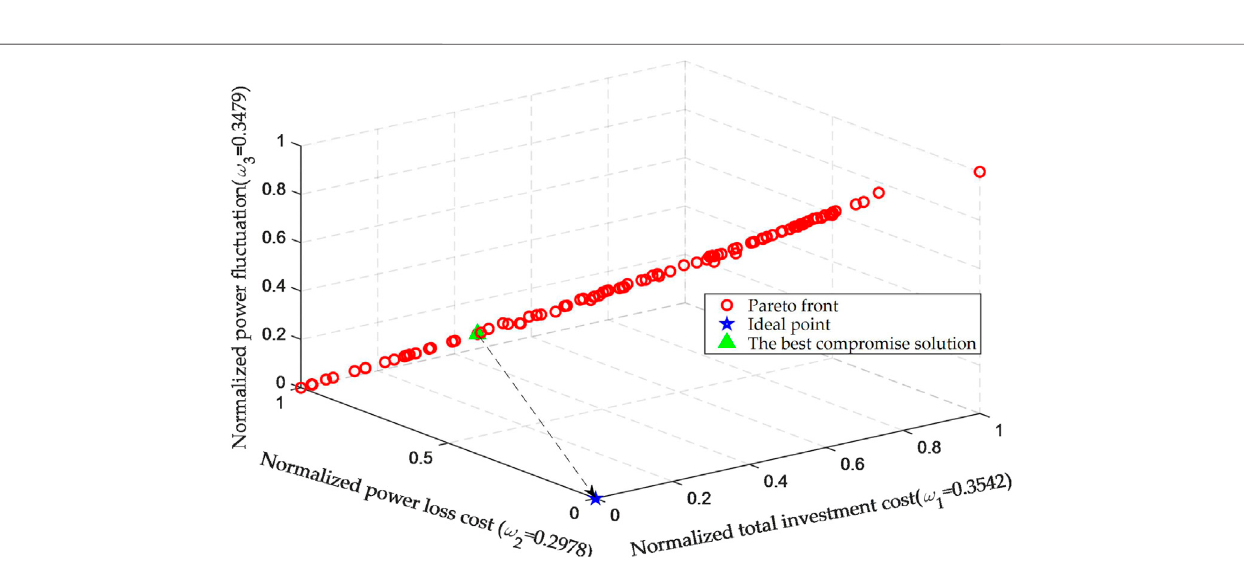
FIGURE 9 | The schematic diagram of IPDM based on MMSSA.